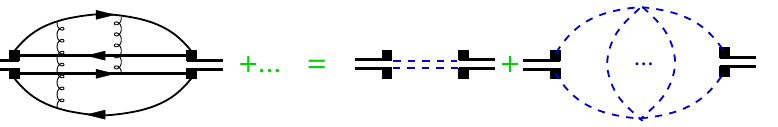
Figure 7. Schematical composition of a tetraquark-adequate QCD sum rule of flavor-preserving type: tetraquark-phile contributions at QCD level, at hadron level counterbalanced by non-separable meson contributions (blue dashed lines), and perhaps those of tetraquark poles (blue dashed double line)